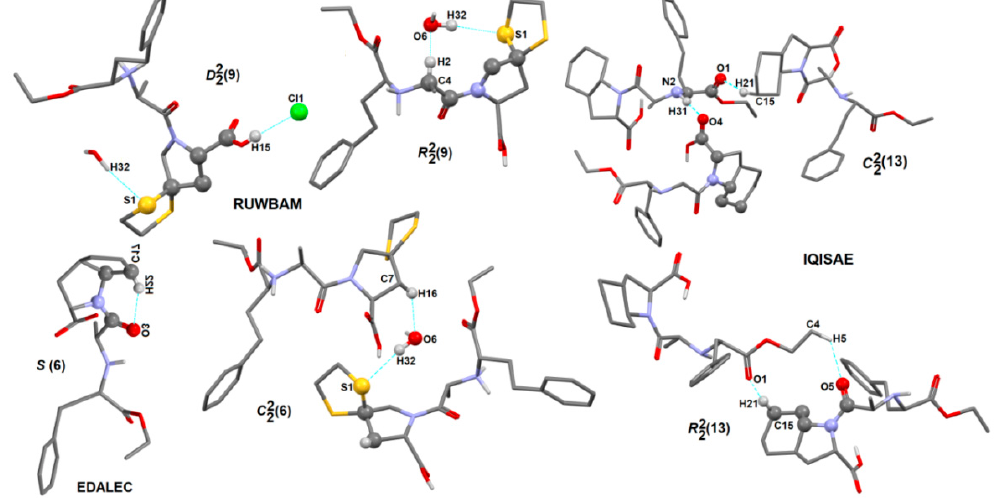
Figure 12. Proline-based synthon patterns in substitued proline-based ACEI.